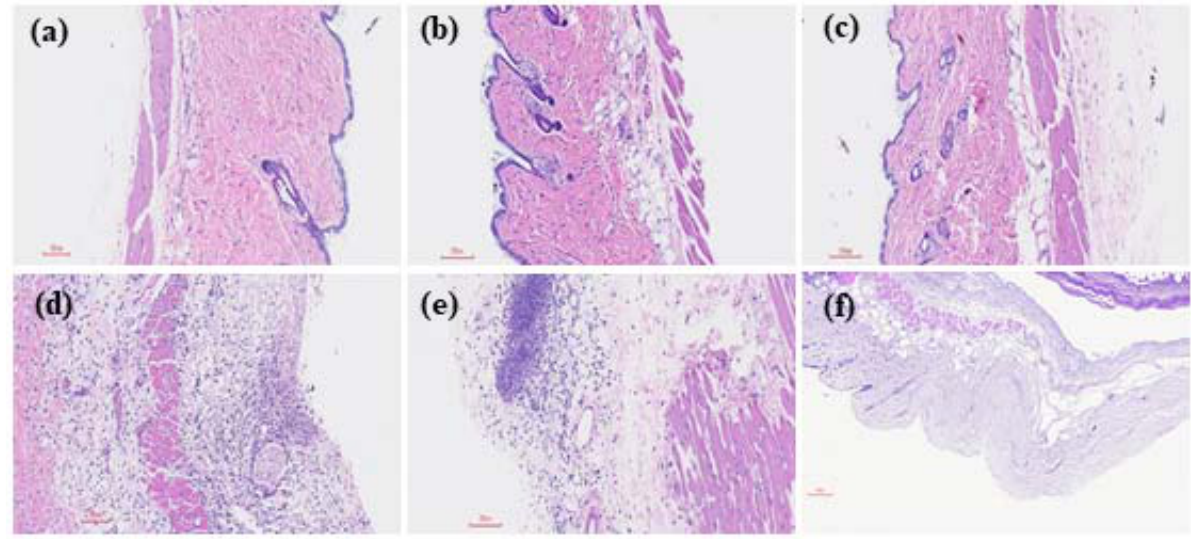
Figure 2. Histological examination of the skin in GAS-infected WT, IL - 33 -KO and ST2 -KO mice. Groups of six WT, IL - 33 -KO and ST2 -KO mice were inoculated via the intra-air pouch route with PBS or 3 × 10 8 S. pyogenes NZ131 cells per mouse. The mice were sacrificed at 48 h post-infection, and then the skin sections were made and stained with H&E staining as described in Materials and Methods. The representative results are shown. ( a ): WT mouse with PBS treatment ( × 100); ( b ): IL - 33 -KO mouse with PBS treatment ( × 100); ( c ): ST2 -KO mouse with PBS treatment ( × 100); ( d ): WT mouse with GAS treatment ( × 100); ( e) : IL - 33 -KO mouse with GAS treatment ( × 100); ( f ): ST2 -KO mouse with GAS treatment ( × 100).